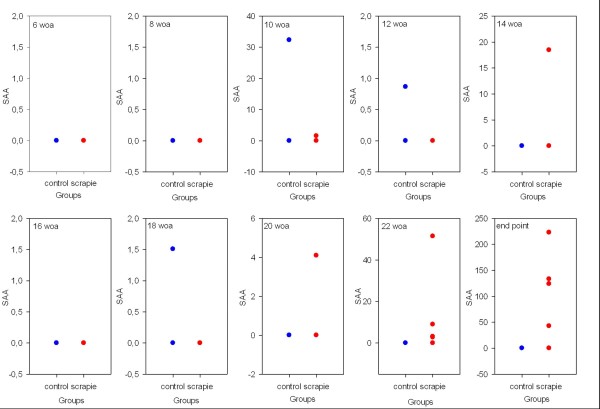
Comparison of difference in SAA levels in serum between healthy controls and scrapie infected sheep from six to 23/24 weeks of age. Each of the individual five scrapie samples (red dots) and four control samples (blue dots) are presented individually as a single dot to indicate the measured serum amyloid A (SAA) level which is presented on y-axis in μg/ml. At most time points, individual samples in both groups were below the detection range of the SAA kit, and thus the dots appear on top of each other as one single dot at 0.0 μg/ml.